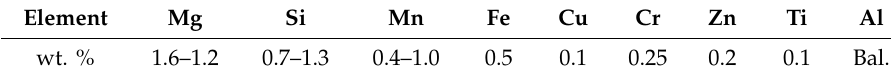
Table 1. Chemical composition of AA6082 alloy (in wt. %).